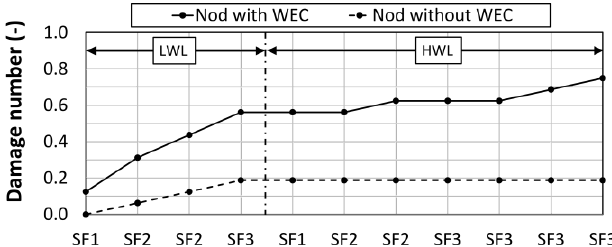
Fig. 19. Damage number N od of the toe berm with and without the h-WEC integrated into the